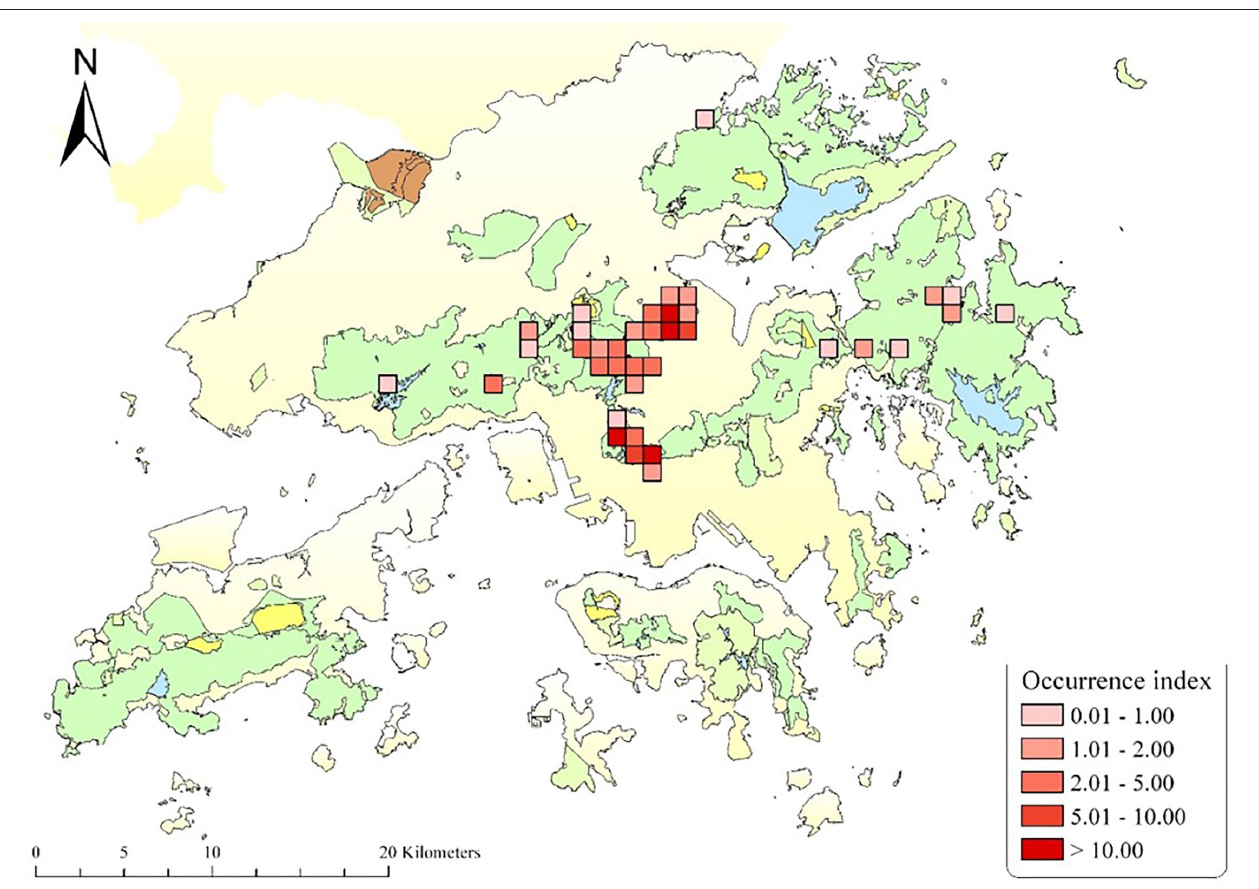
FIGURE 1 | Map of Hong Kong displaying the trapping sites of the macaques for the contraceptive program, between 2009 and 2021. The Occurrence Index is defined as the number of photographs taken divided by the total amount of trapping effort in 100 camera working days [detailed in ( 4)]. The map is provided by the Agriculture, Fisheries, and Conservation Department, The Government of the Hong Kong